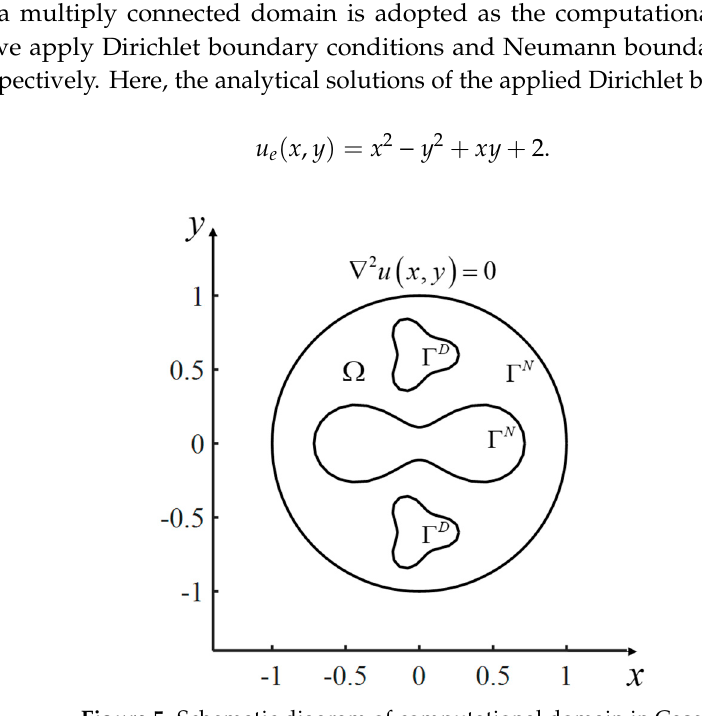
Figure 6. The distribution of numerical solution in Case 2. Table 2. The maximum absolute error for Case 2. N